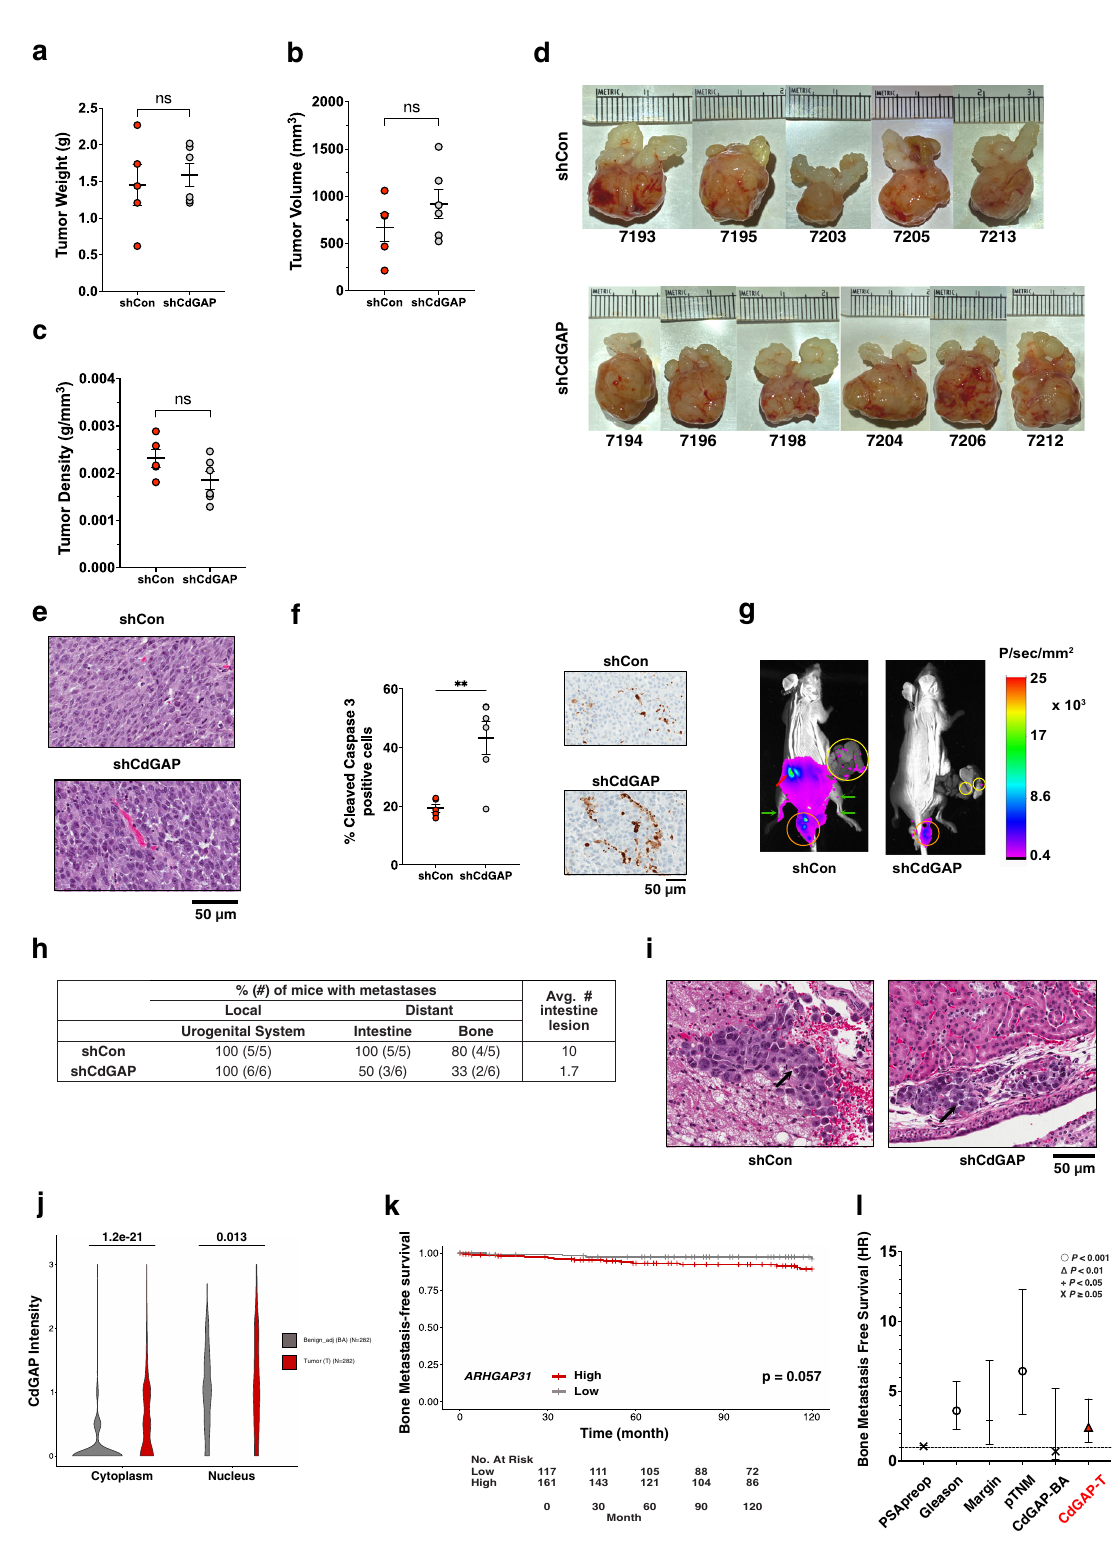
Methods Mortensen and TCGA analyses . The Mortensen dataset (GSE46602) 37 is a microarray-based dataset (Affymetrix U133 2.0 Plus), comprising 36 laser microdissected prostate cancer samples and 14 normal prostate samples. Data fi les with probes values (.CEL fi les) and sample data were downloaded from NCBI Gene Expression Omnibus (GEO) database (GEO, http:// www.ncbi.nlm.nih.gov/geo/) using getGEO-function of GEOquery